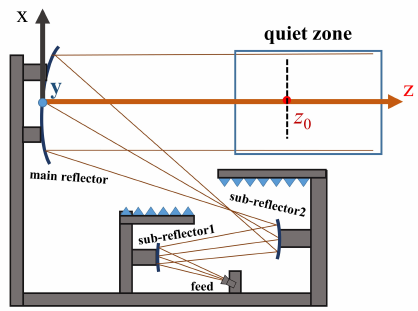
Figure 7. The plane view of the Cassegrain Gregorian tri-reflector